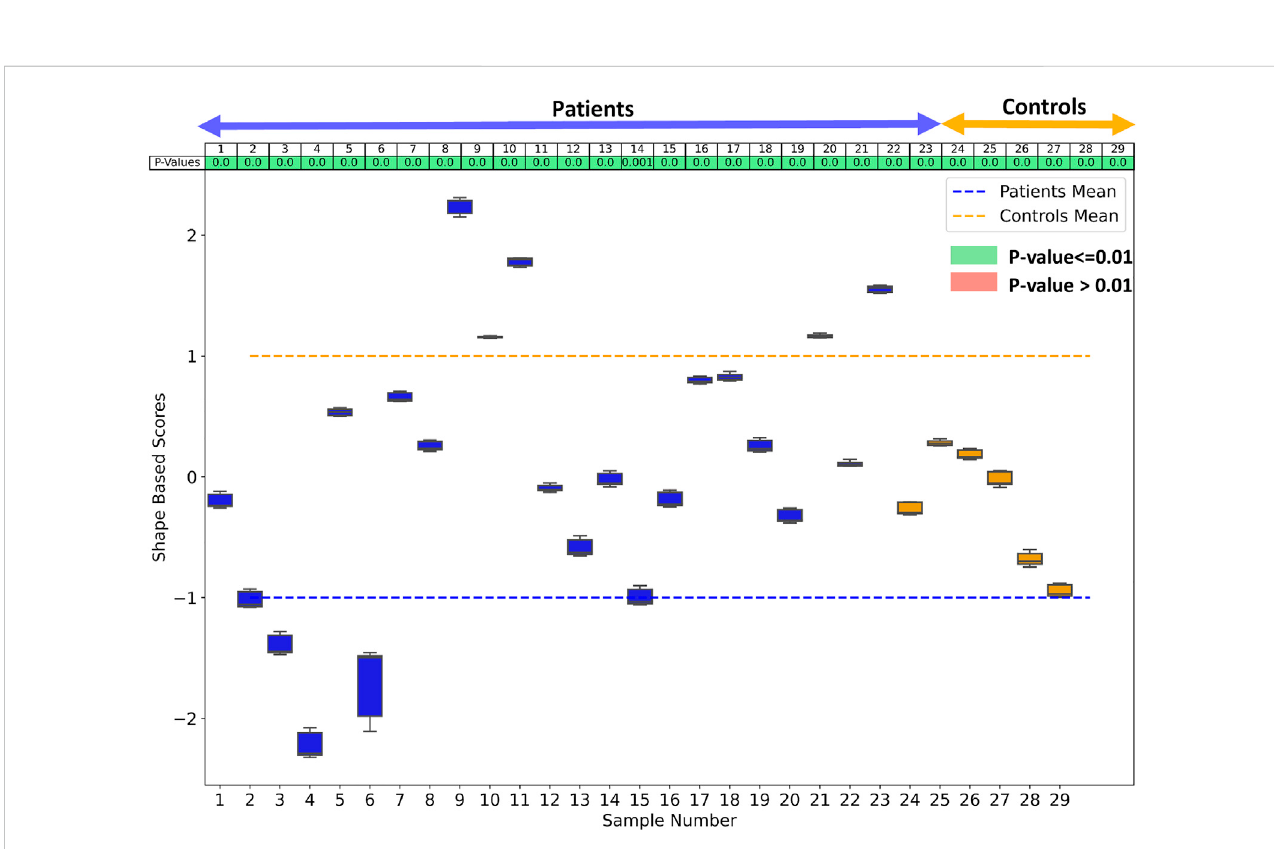
FIGURE 9 Thebox whiskerplotshows thedistribution oftheshape-basedscores foreach samplefromtendifferentshapemodelsgeneratedto study theeffect of data imbalance. The table at the top of the plot shows the p -values of the shape-based